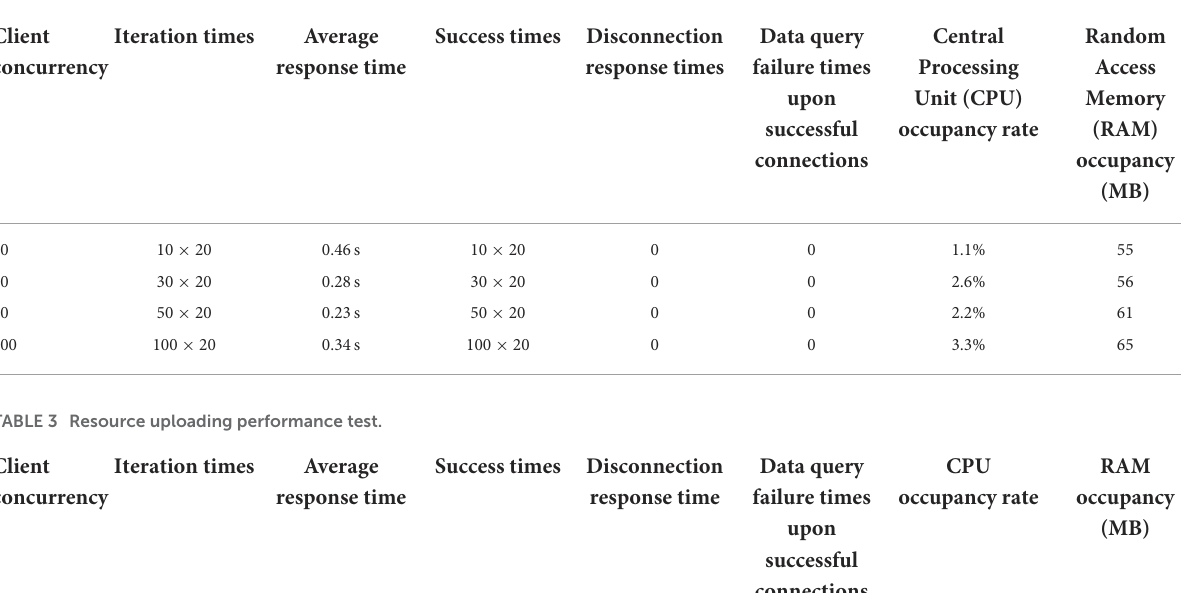
TABLE 2 Test results of system login service performance.